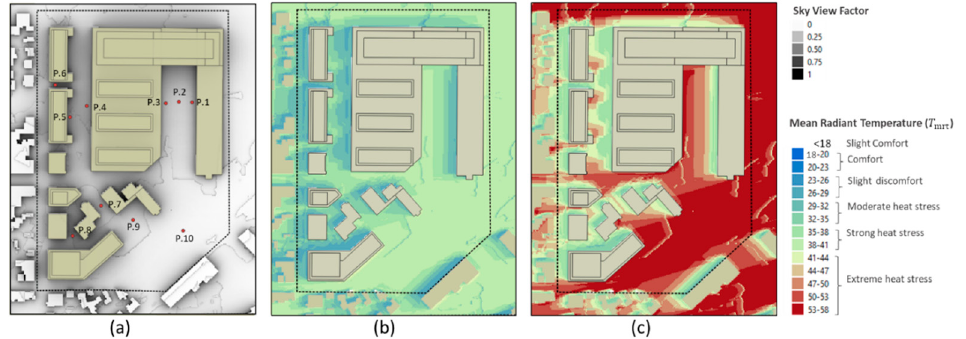
Figure 10. ( a ) The distribution of the sky view factor resulted from the building design and the spread of focal spots all over the site; ( b ) the distribution of mean daytime T mrt classified by PET index; ( c ) the distribution of mean T mrt classified by PET index through the hottest period of the days (12:00–19:00). Table 3. Thermal sensitivity and grads of physiological stress, according to Mayer and Matzaraki [44]. PET ( ◦ C) Range